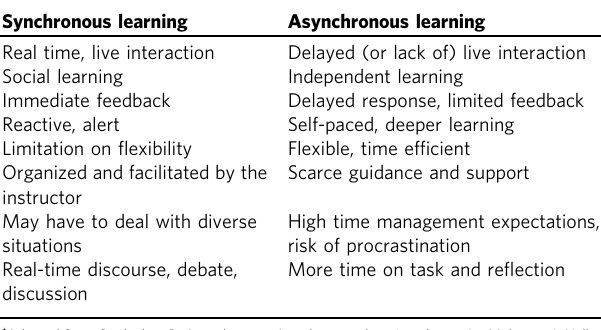
Table 1 Comparisons of the two types of online